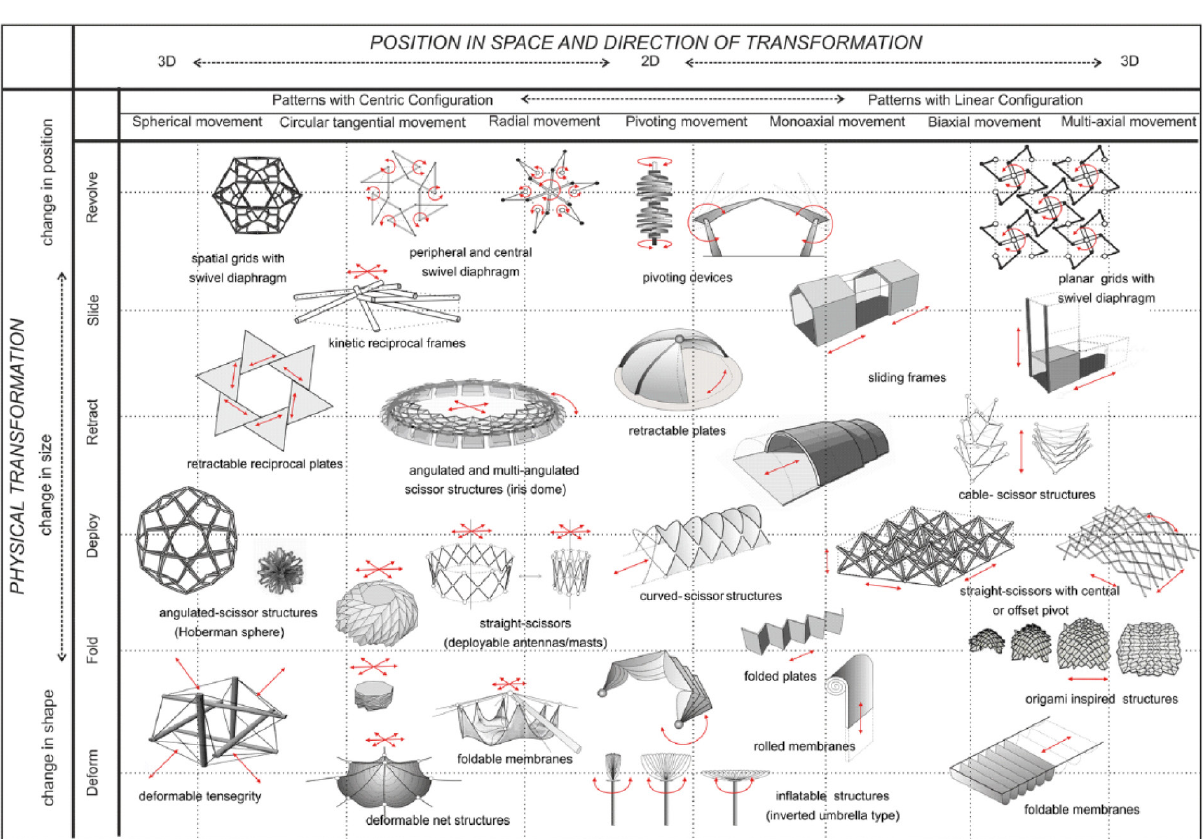
Figure 9: Classification of Schaeffer and Vogt from 2010